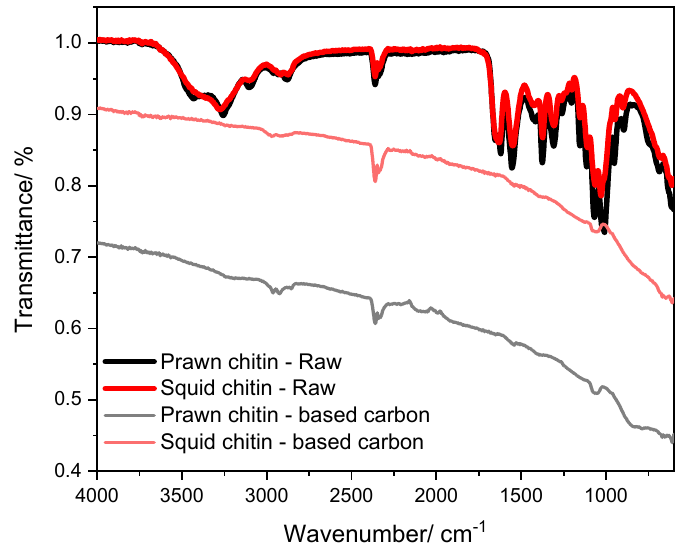
Figure 5. ATR-FTIR spectra of raw prawn and squid chitin carbon precursors, as well as the chitin- based carbons (1000 °C, 1 h).